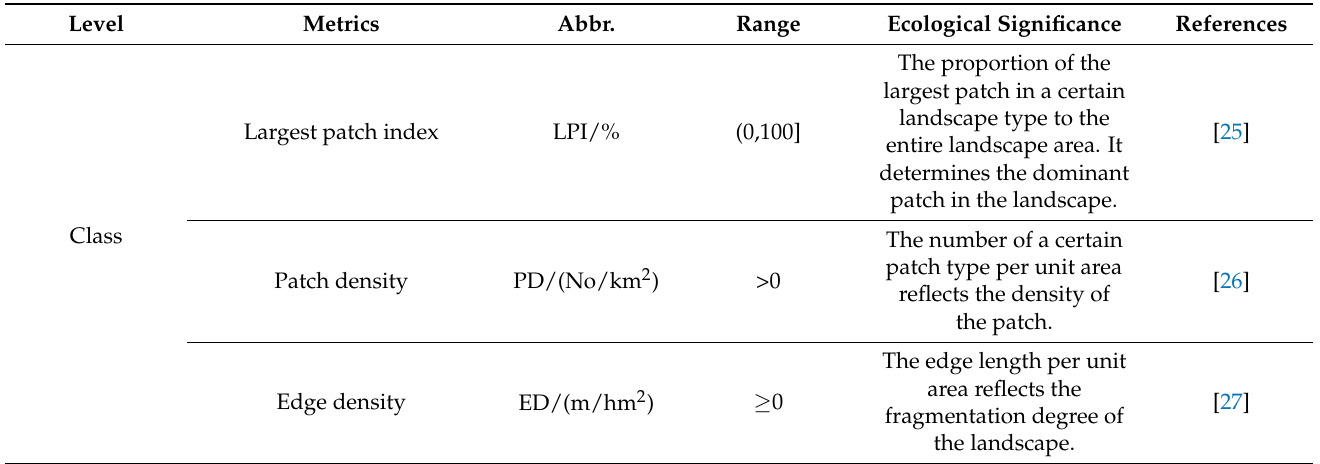
Table 1. Landscape metrics and the associated ecological